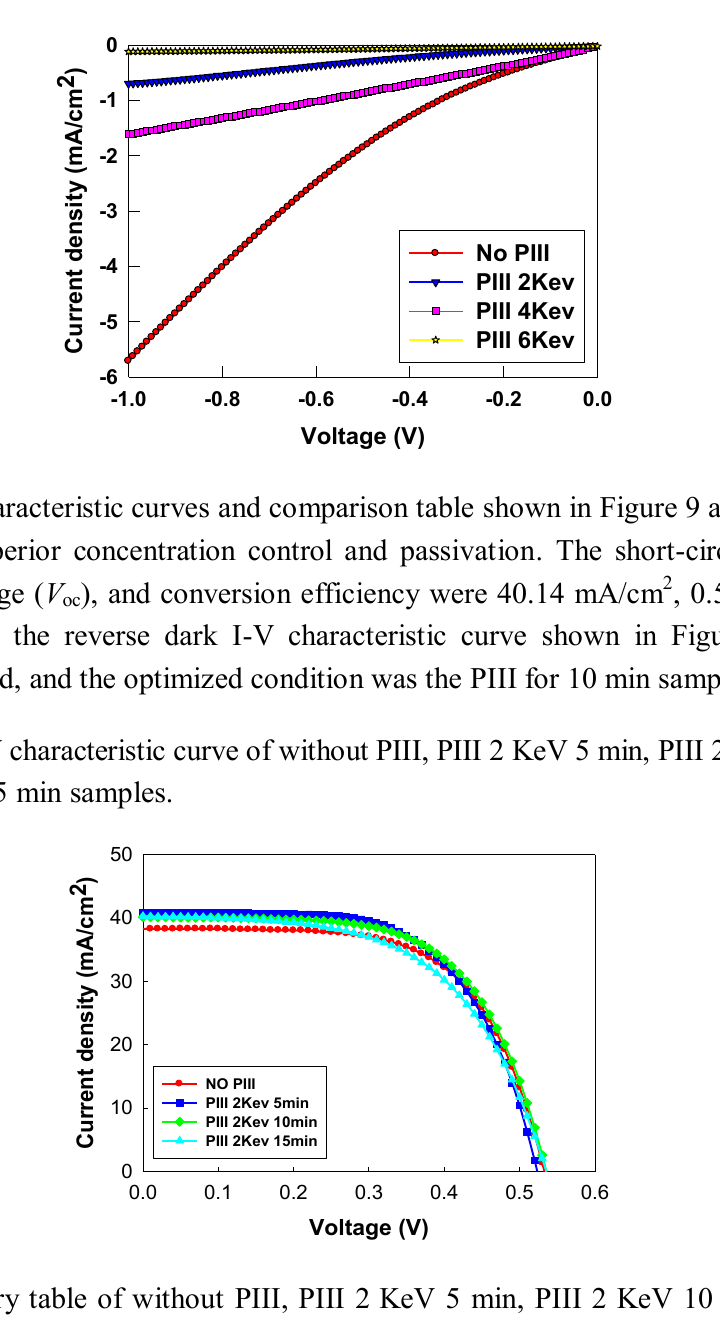
Figure 8. The reverse dark I-V characteristic curve of solar cell (using heterojunction solar cell with AlO passivation). x